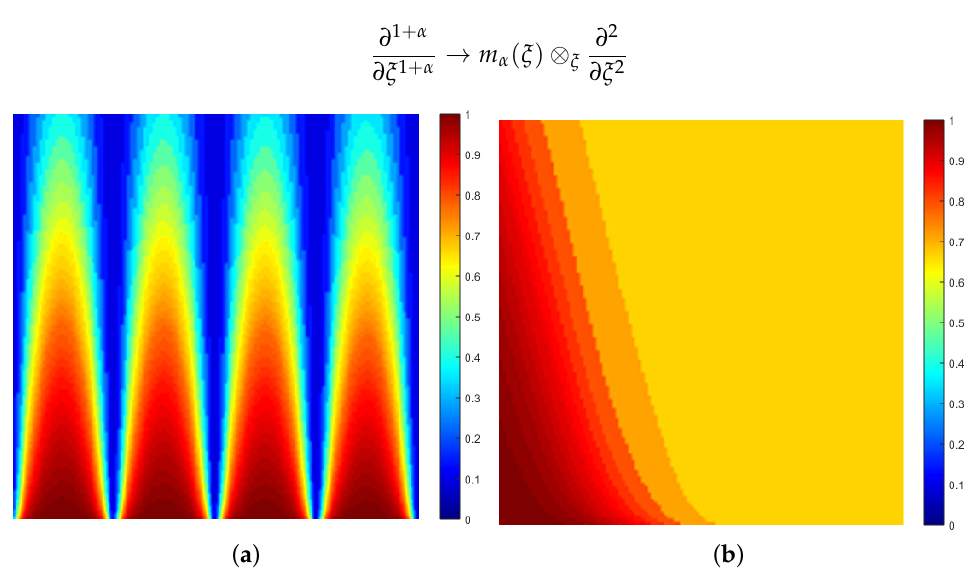
Figure 9. Example of two solutions given by Equation (76). In both cases, the horizontal axis and the vertical axis are of space x and time t , respectively, where ( 0,0 ) is the lower left-hand corner of the map. ( a ) Space-time map of the function | u β ( x , t ) | 2 , x ∈ [ 0,1 ] , t ∈ [ 0 + ,1/ k ] , where u β ( x , t ) is given by Equation (76) for k = 4 π and α = 0.999; ( b ) space-time map of the function | u ( x , t ) | 2 , x ∈ [ 0,1 ] , t ∈ [ 0 + ,1/ k ] , where u ( x , t ) is given by Equation (76) for k = 4 π and β β α =